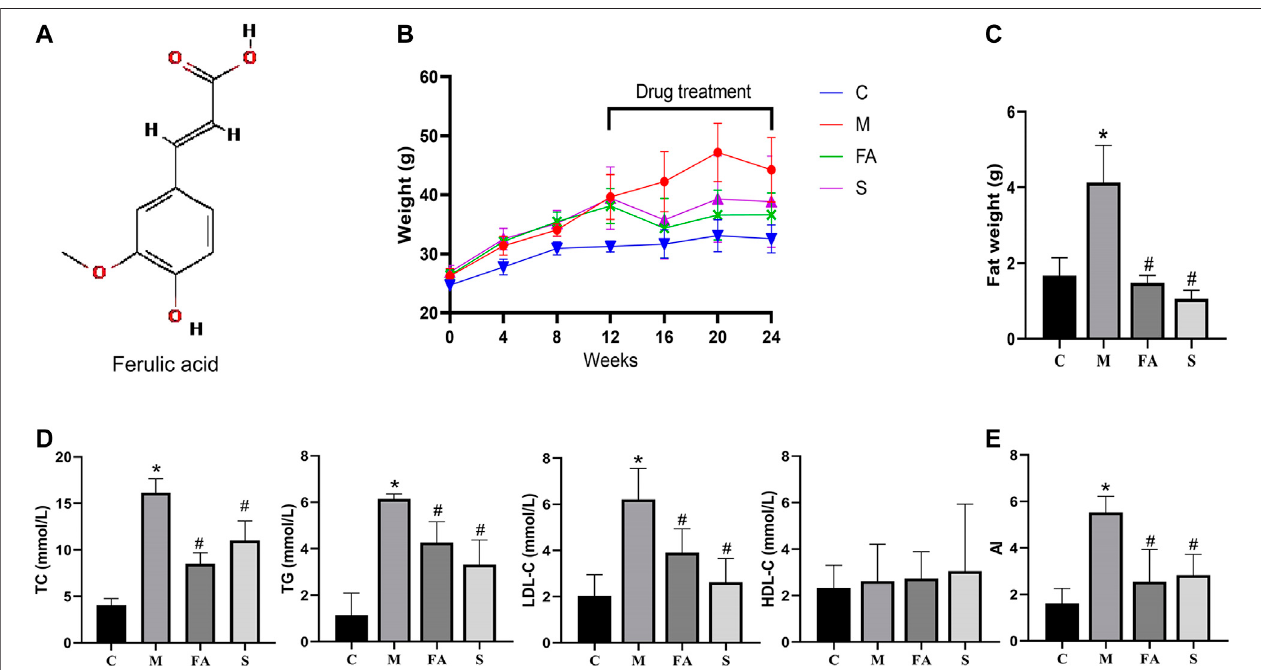
FIGURE1| FAregulatedlipidlevelsinHFD-fedApoE − / − mice (A) Chemicalstructure ofFA. (B) Thechangeofbodyweight. (C) Abdominaladipose weightofmice. (D) Levelsofserumlipids(TC,TG,LDL-C,HDL-C)inpergroup. (E) Atherogenicindexofvariousgroups.Controlgroup(C),modelgroup(M),Ferulicacidtreatmentgroup (FA), simvastatin treatment group (S). n (cid:2) 4. * p < 0.05, ** p < 0.01; as compared to the control group. # p < 0.05; as compared to the model